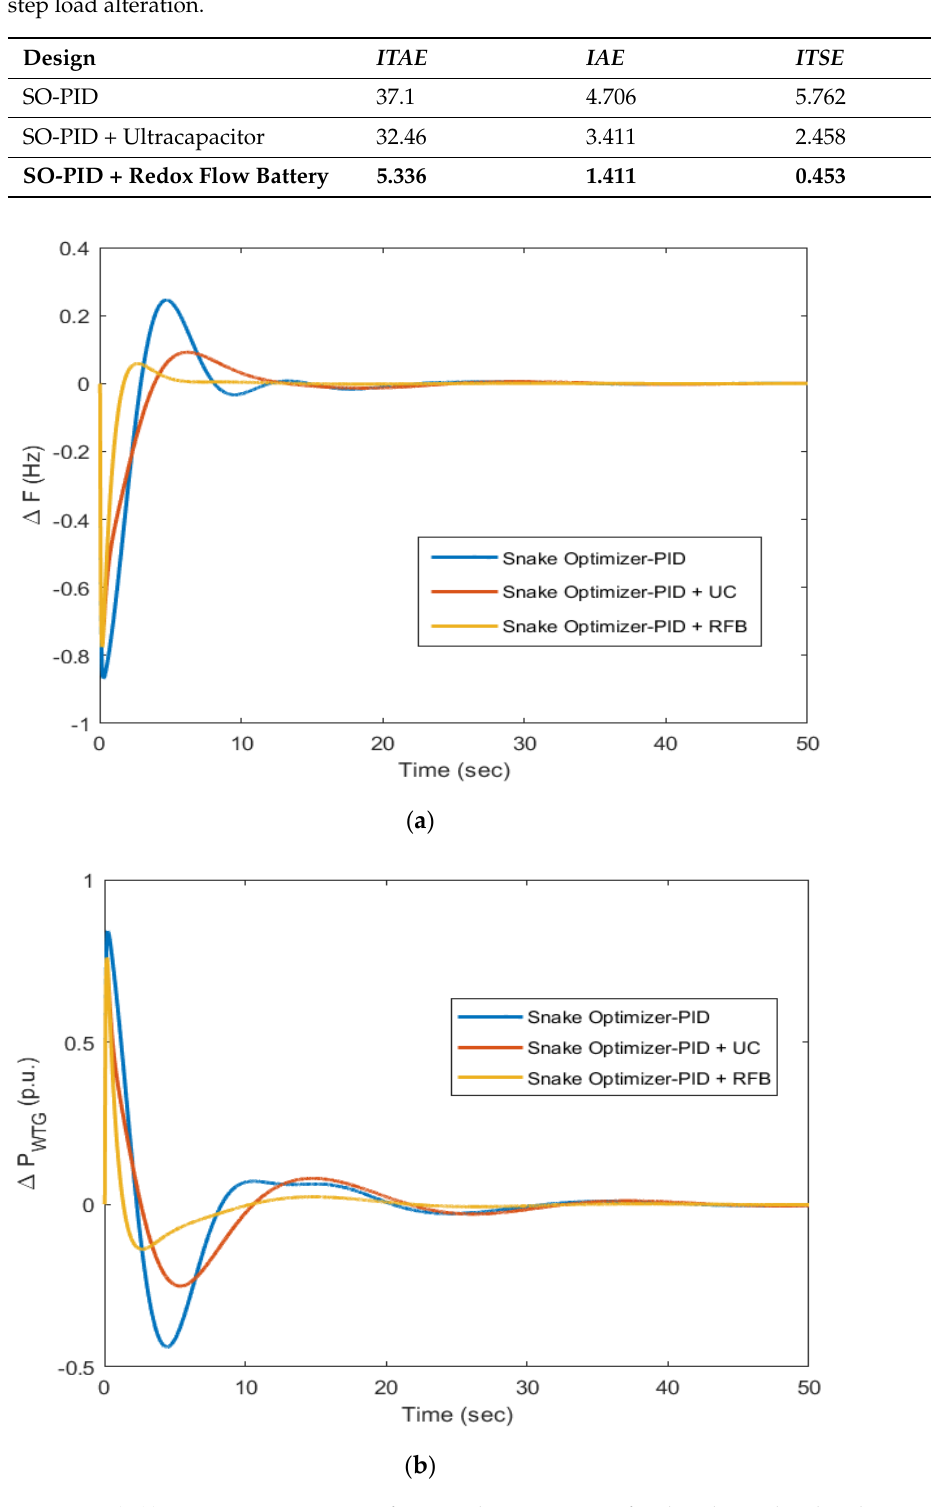
Figure 11. ( a , b ) Comparative output of PID with a UC or RFB for diesel–wind isolated system for a 1.0 p. u. step load alteration.